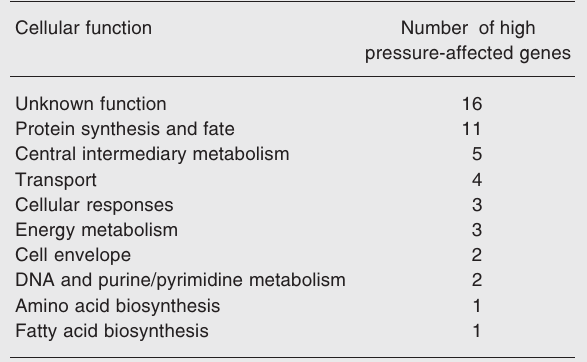
Table 1. Functional classification of high pressure (45 MPa/30 min)- induced and repressed genes, respectively. Cellular